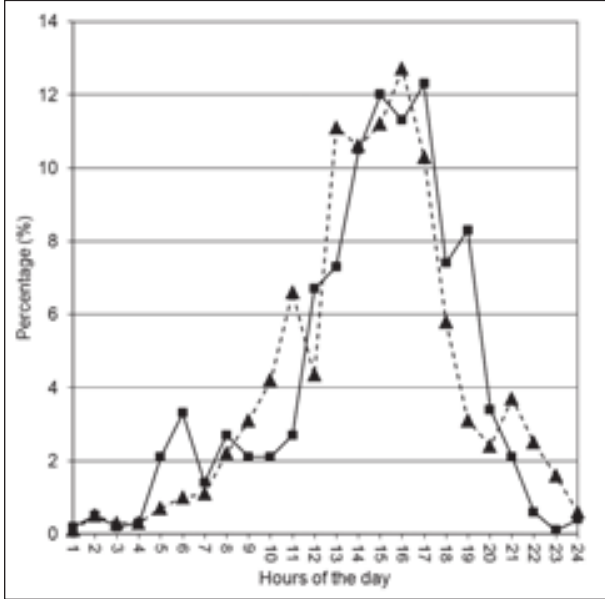
Figure 1. Patterns of diurnal periodicity of Monilinia spp. (Eperjeske, Hungary, 2013 and